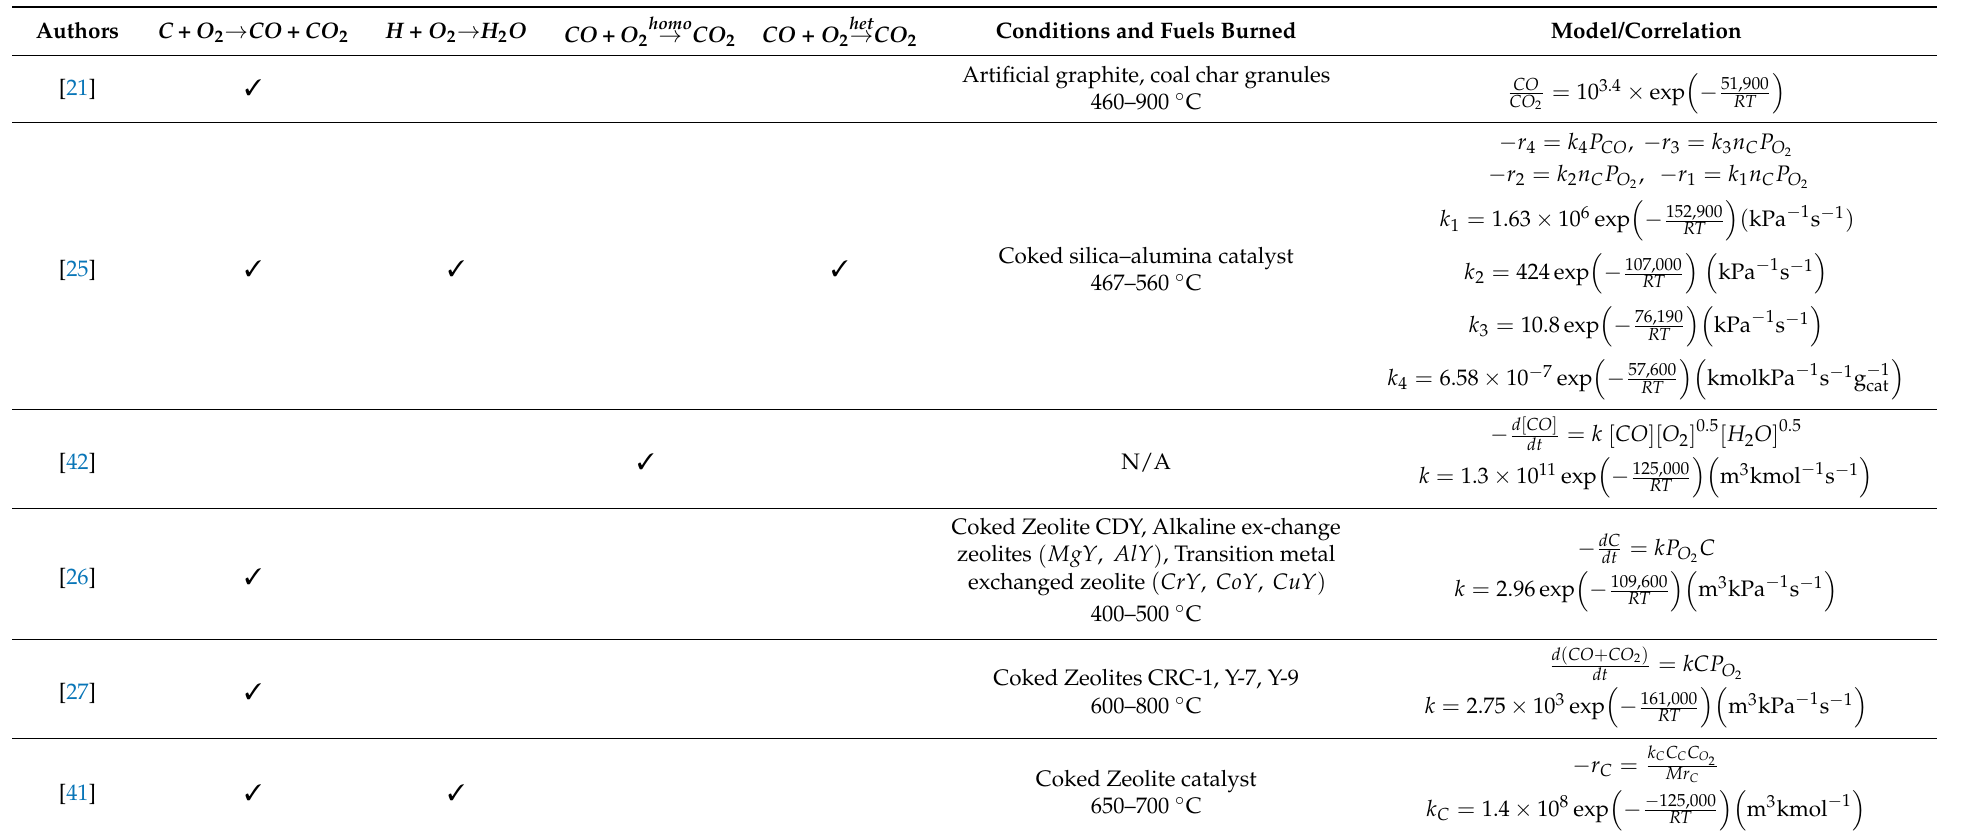
Table 2. Kinetic studies of FCC regenerator